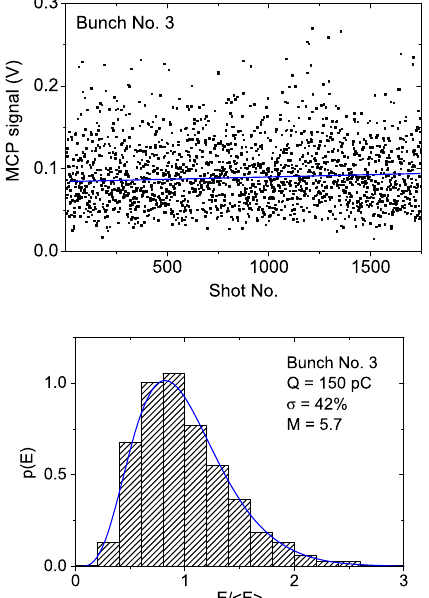
FIG. 6. Experimental data from FLASH operating in the linear regime. The active undulator length is 13.5 m (three undulator modules). The radiation wavelength is 13.5 nm. Left plot: Raw data of MCP detector for bunch number 3. The solid curve shows the averaged value. Right plot: Probability distribution of the radiation energy for bunch number 3. The solid curve represents the gamma distribution with M ¼ 5 . 7 .